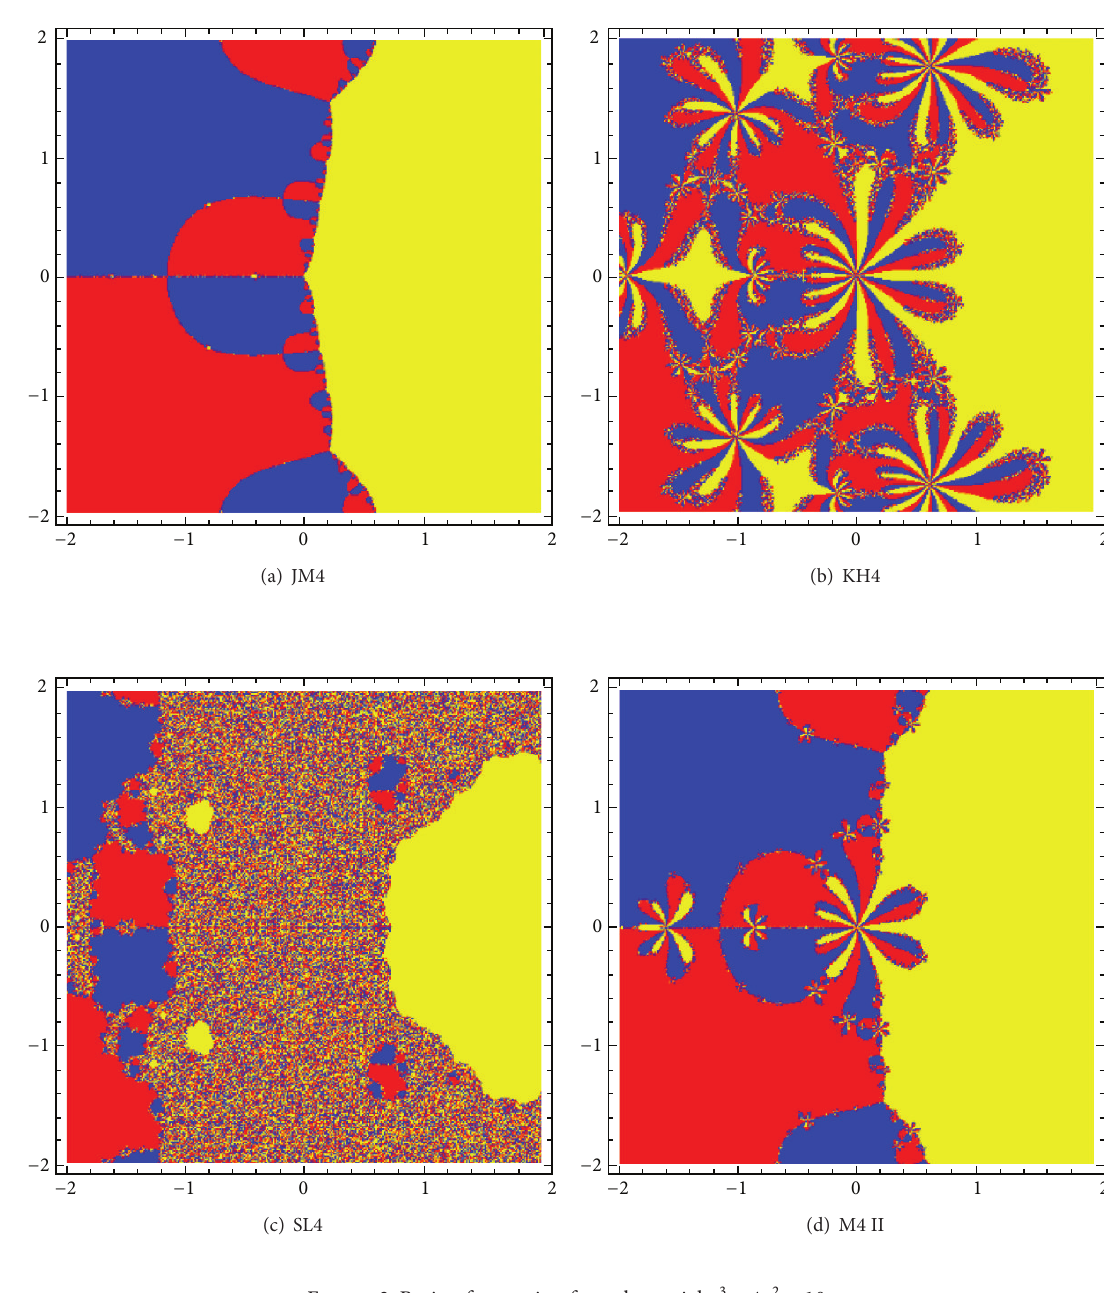
Figure 2: Basin of attraction for polynomial 𝑧 3 + 4𝑧 2 − 10